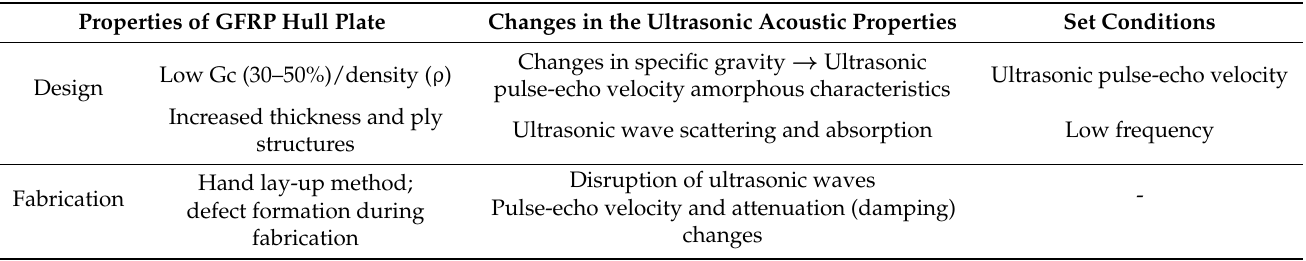
Table 1. The GFRP hull plate properties and ultrasonic inspection set